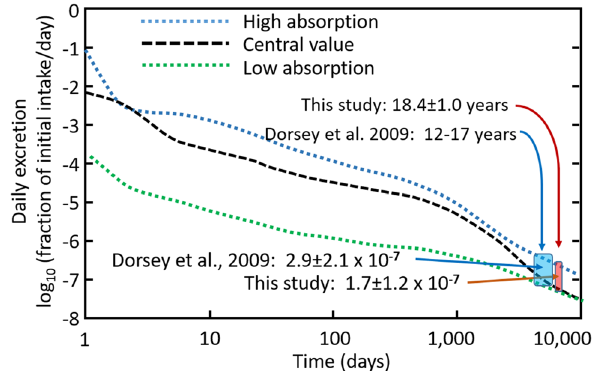
Figure 1. Estimation of current urinary DU excretion from DU oxides absorbed 18 years earlier. From the Human Respiratory Track Model (HRTM) for inhalation of uranium oxides we estimated the daily urinary excretion of DU, expressed as a fraction of the original inhaled dose (log scale), and plotted as a function of days since inhalation (log scale). In the sample of veterans studied, the duration between potential inhalation (in the first half of 1991 during the conflict) and the urine collection (November 2008–June 2010) was 6720 ± 365 days or 18.4 ± 1.0 years, shown as the width of the small red box. The analogous region from Dorsey et al. 20 discussed in the text is shown in the larger blue box. Three curves showing fractional uranium excretion predicted by the combined dissolution-storage-excretion function of the HRTM for uranium oxide particulates are shown; these represent “Low” and “High” absorption curves during dissolution and metabolism of compounds of uranium oxide with contrasting chemical form and solubilities. The figure is modified from 8,24 using the HRTM model with aerosol and oxide physicochemical characteristics summarized 8 and taking into account the uncertainty in the HRTM model parameters 23